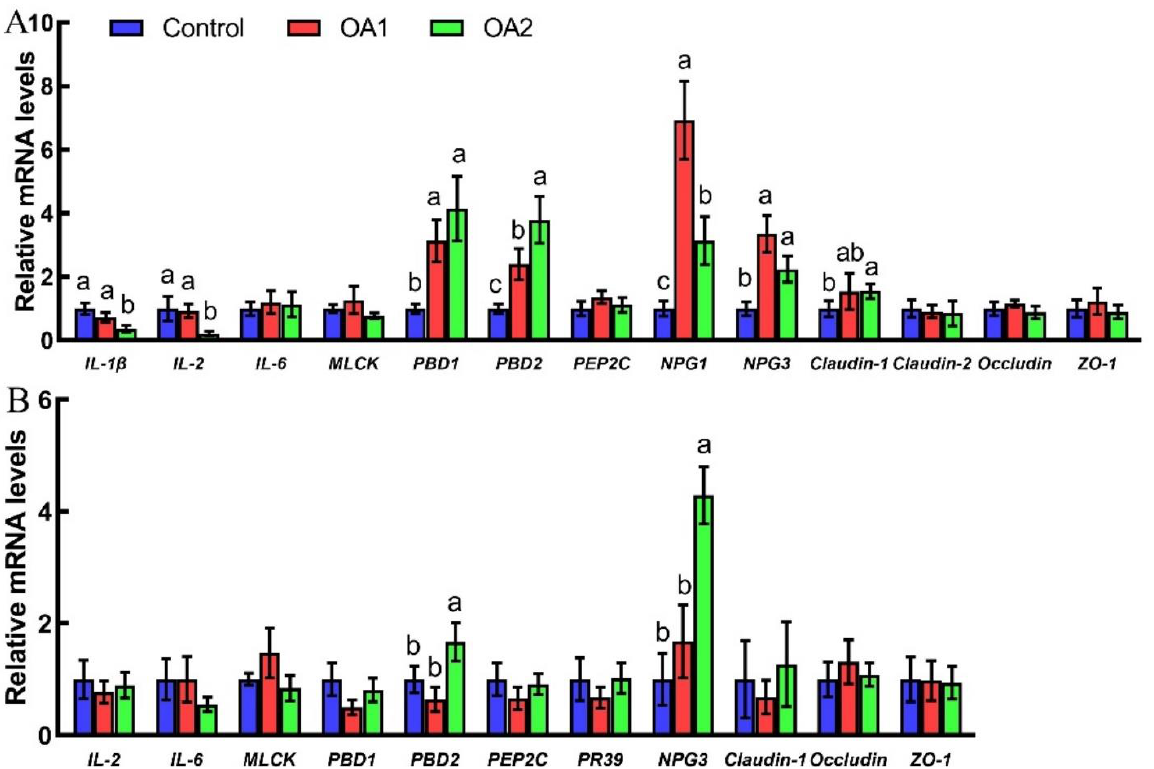
Figure 2. Effects of acidifiers on relative mRNA abundance of cytokines, tight junction genes, and defense peptides in the jejunum of piglets at day 14 ( A ) and day 49 ( B ). Values are means ± SD, n = 6. Labeled means without a common letter differ, p < 0.05.